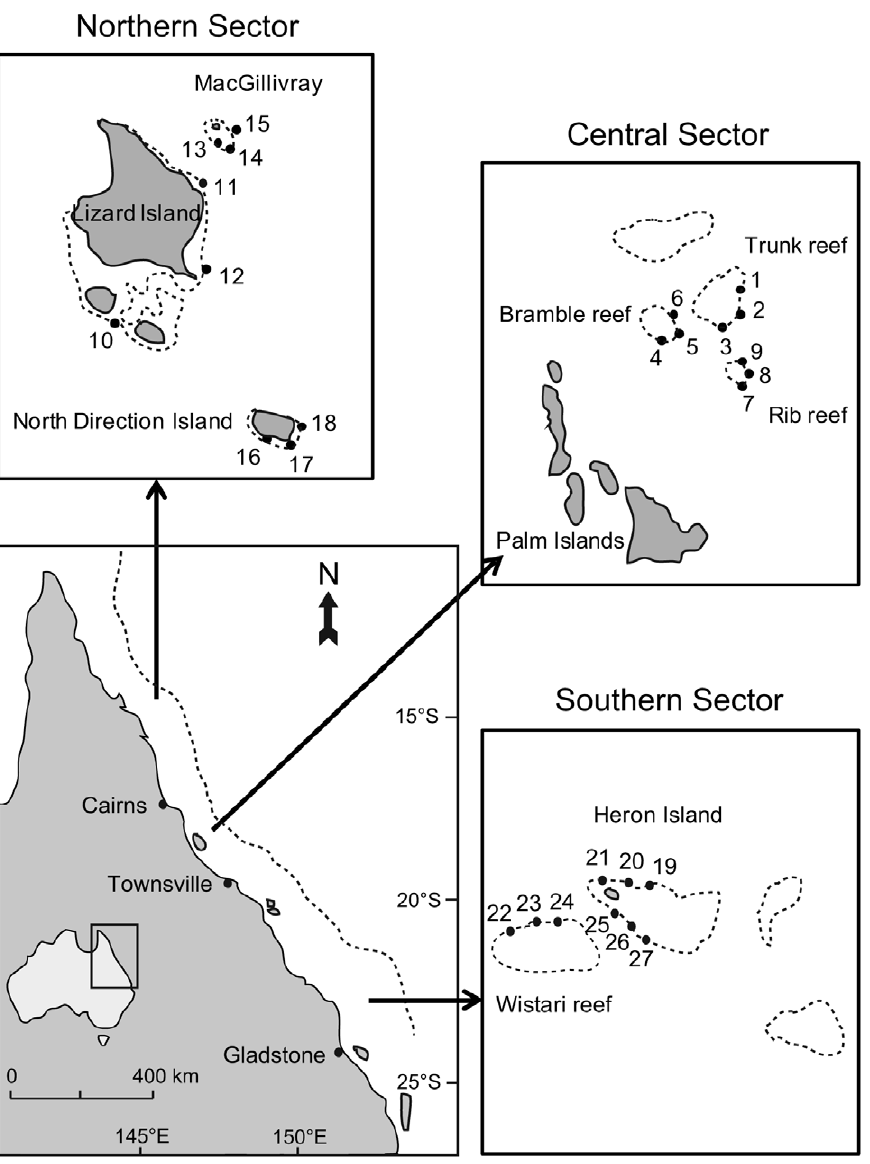
Figure 1. Map of Eastern Australia showing the Great Barrier Reef region with the three sectors chosen for this study. At each sector, three mid-shelf reefs with three sites each on the reef crest have been surveyed.